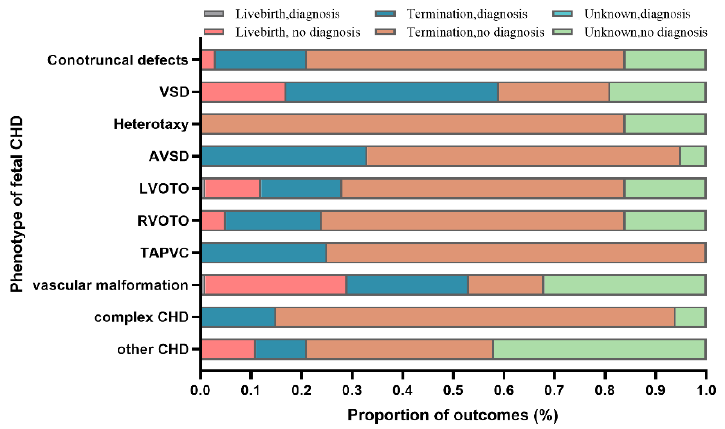
Figure 3. Pregnancy outcomes associated with a phenotype of fetal CHDs. A total of 138 fetuses had conotruncal defects, 60 fetuses had a septal defect, 25 fetuses had heterotaxy, 39 fetuses had AVSD, 47 fetuses had LVOTO, 42 fetuses had RVOTO, 4 fetuses had TAPVC, 22 fetuses had a vascular malformation, 33 fetuses had complex CHD, and 17 fetuses had other CHD. VSD: ventricular septal defect; AVSD: atrioventricular septal defect; LVOTO: left ventricular outflow tract obstruction; RVOTO: right ventricular outflow tract obstruction; TAPVC: total anomalous pulmonary venous connection.